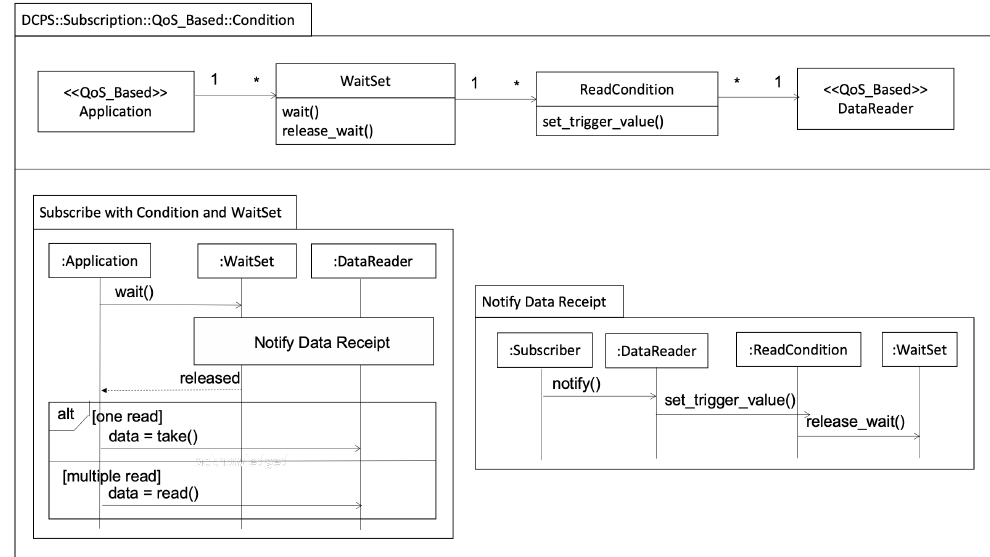
Figure 16. Condition